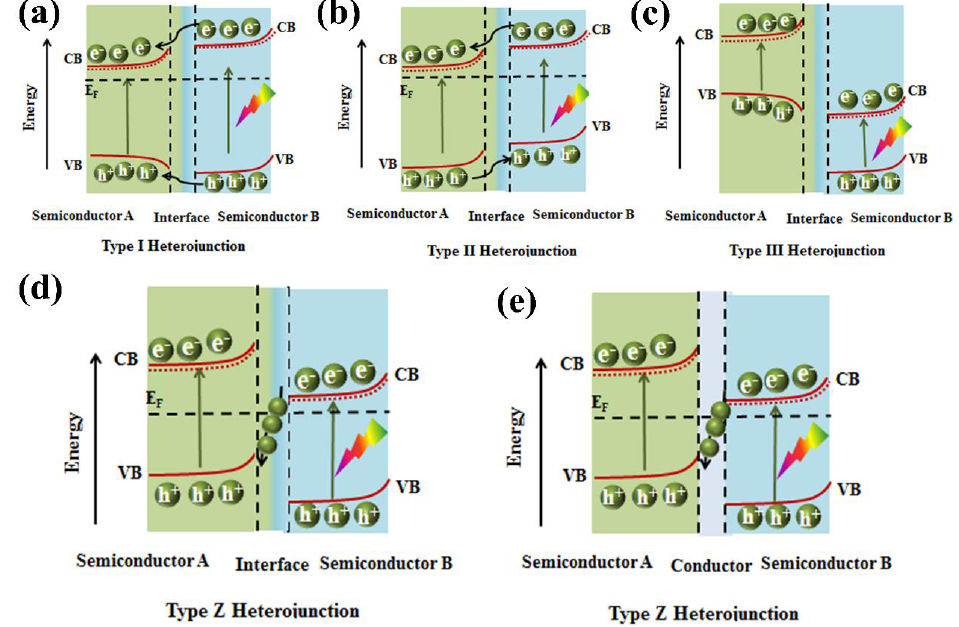
Figure 16. Schematic illustration of the transfer of electron-hole pairs for various types of hetero- junction composite films: ( a ) Type I, ( b ) Type II, ( c ) Type III, ( d ) semiconductor-semiconductor Z-scheme, and ( e ) semiconductor-conductor −semiconductor Z-scheme.